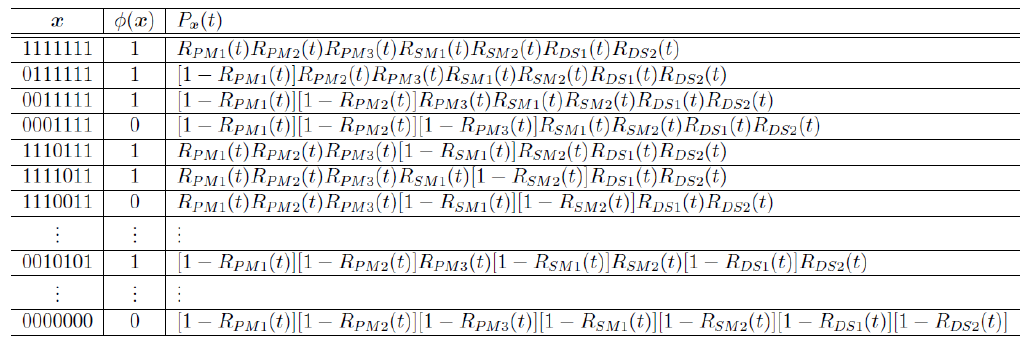
Table 4. Parallel-series reliability function